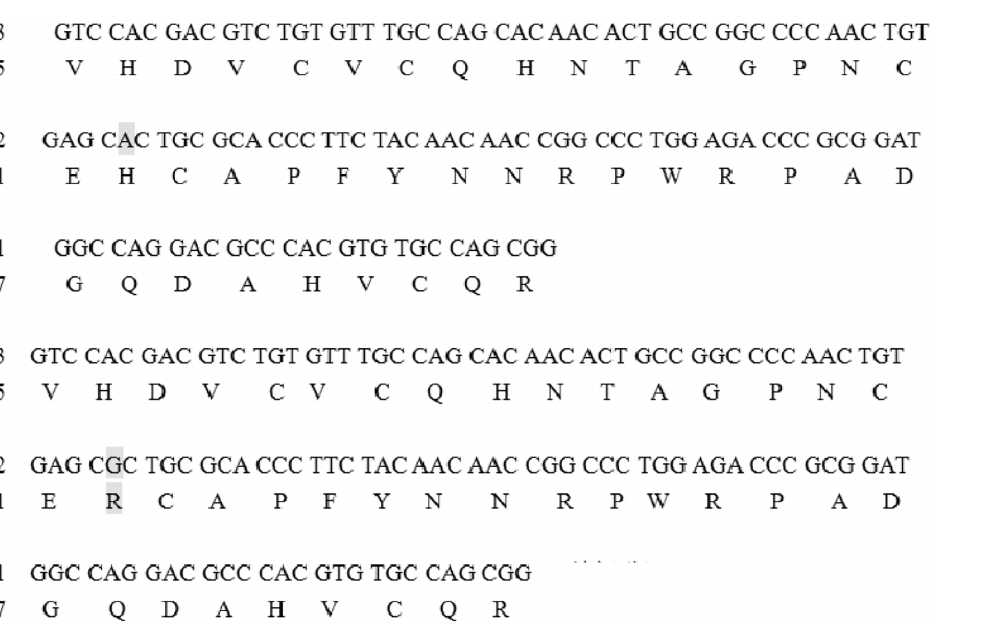
PLOS ONE | DOI:10.1371/journal.pone.0124583 May 8,